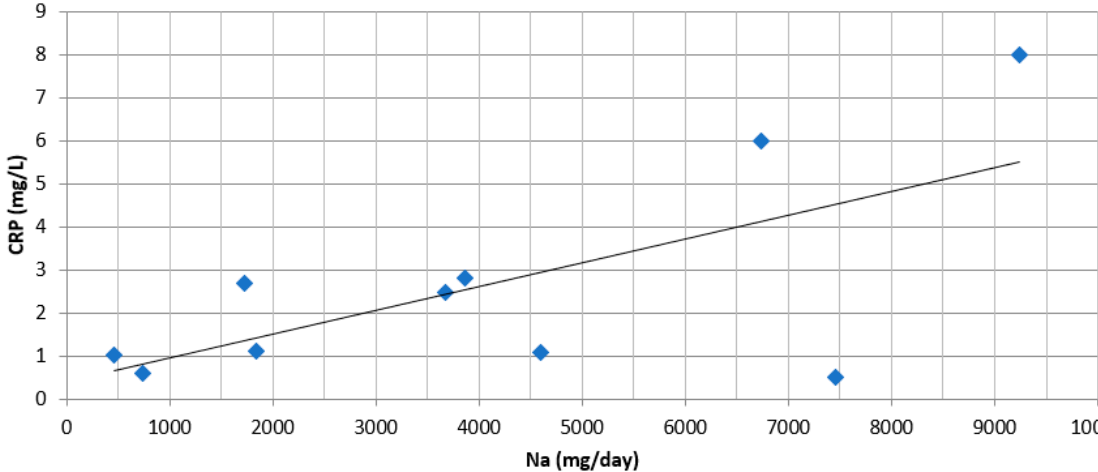
Figure 2. Scatter dot plot of average daily sodium intake (mg/day) and CRP plasma levels (mg/L) per study group. Data from 5 available randomized studies [27,37,38,41,42], after excluding 1 study [13], which evaluated the acute effect (after one meal, every 30 min, for 2 h) of sodium intake. Range of duration of sodium intervention was 14 to 112 days. r = 0.663; p =